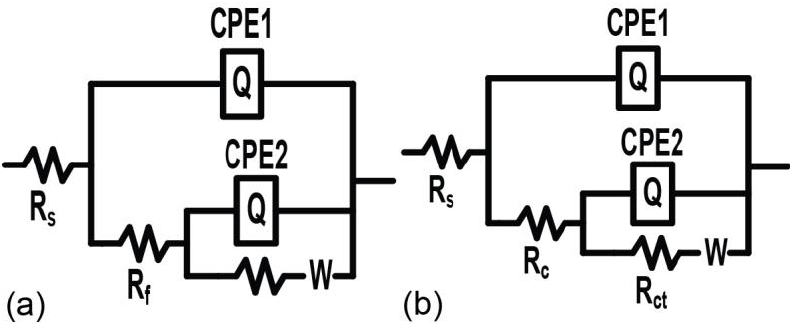
Figure 6. The equivalent electrical circuit model used to fit the experimental data: ( a ) for uncoated Cu and ( b ) Cu/HEA thin films in artificial seawater.